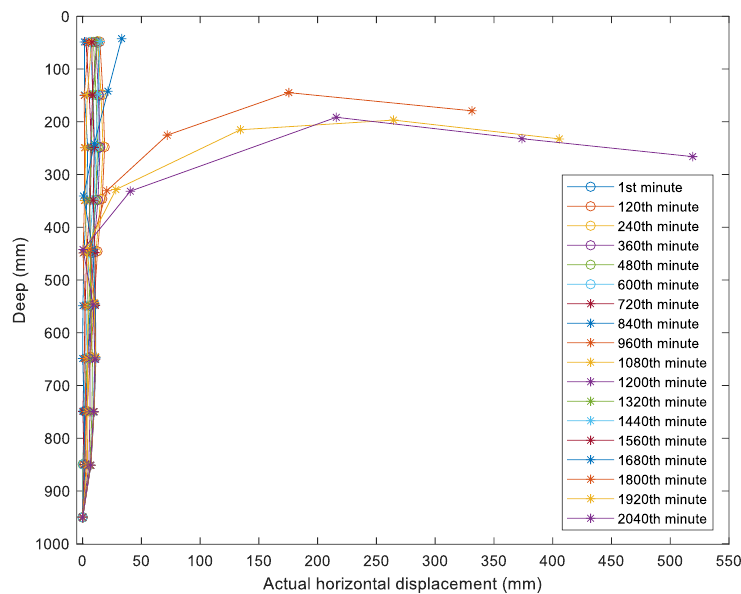
Figure 11. Curve of actual depth deformation.